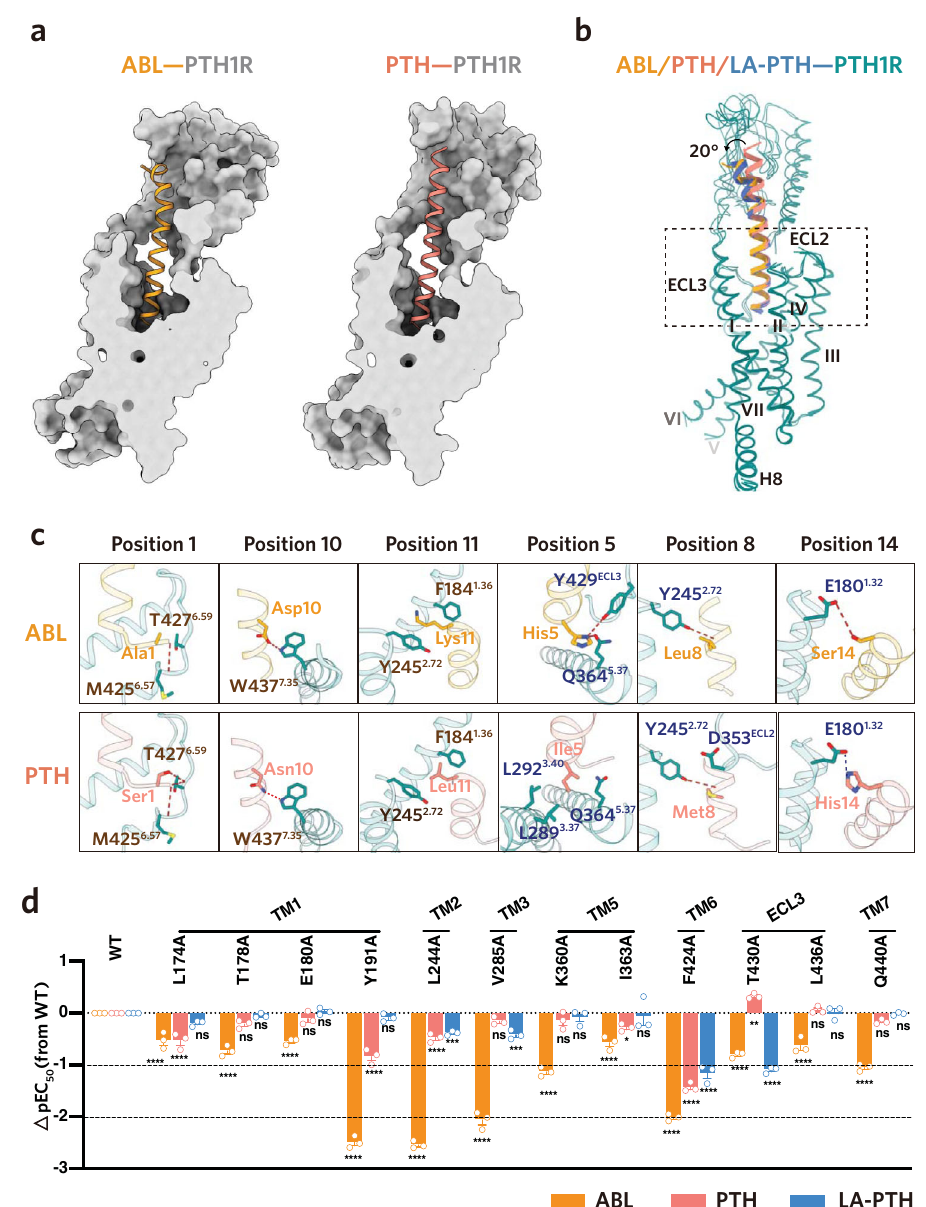
Fig.3|InteractionsofPTHandABLwithPTH1R.a Verticalcross-sectionofPTH – and ABL – binding pocket in PTH1R. b Structural comparisons of the ligand-binding modes between PTH, ABL and LA-PTH. c Detailed interactions of PTH1R with the distinctresidues inthe N-terminalportion of PTHand ABL.Similarinteractions are colored in brown (positions 1, 10 and 11), and the differential interactions are coloredinblue(positions5,8and14).Hydrogenbondsandsaltbridgearedepicted asred and blue dashed lines, respectively. d The ABL – , PTH – andLA-PTH – induced cAMP accumulation assays of the PTH1R variants harboring mutations of the resi- dues involved in the differential recognition of three peptide agonists. Bars represent differences in calculated different peptide agonists potency [pEC 50 ] for each mutant relative tothe wild-typereceptor(WT). Data arecoloredaccording to